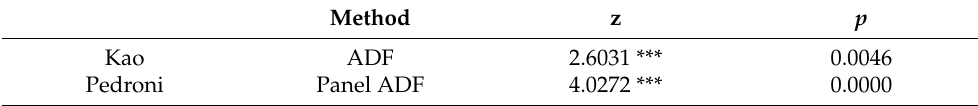
Table 4. Co-integration test.